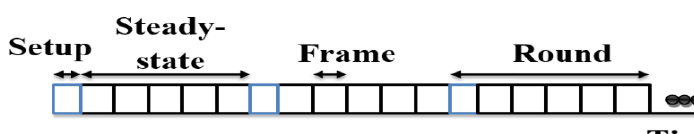
Fig. 2. Timeline Showing Proposed Protocol Operation.